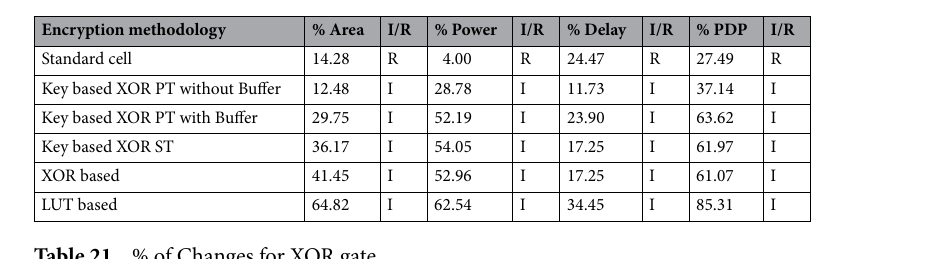
Table 21. % of Changes for XOR